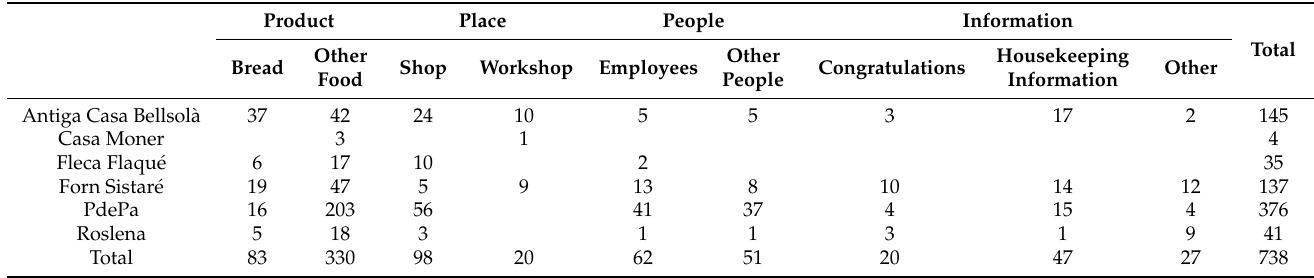
Table 5. The categories and sub-categories represented on the bakeries’ Instagram.